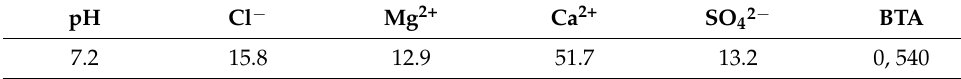
Table 3. Chemical composition of synthetic tap water (ppm) used in